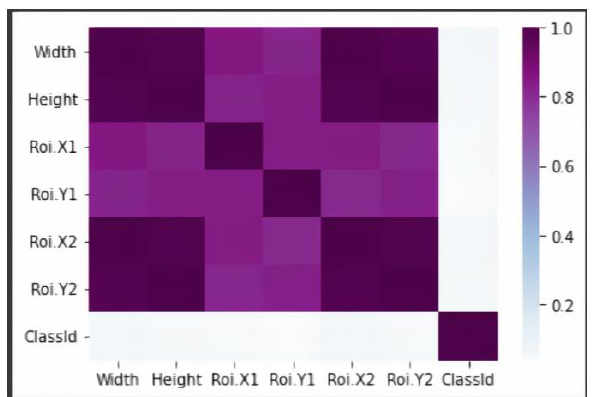
Fig. 9. Relationship Analysis using